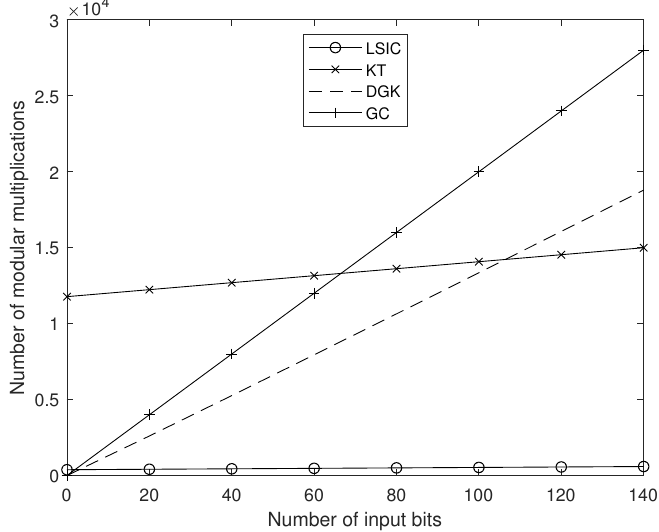
Figure 1. Computational